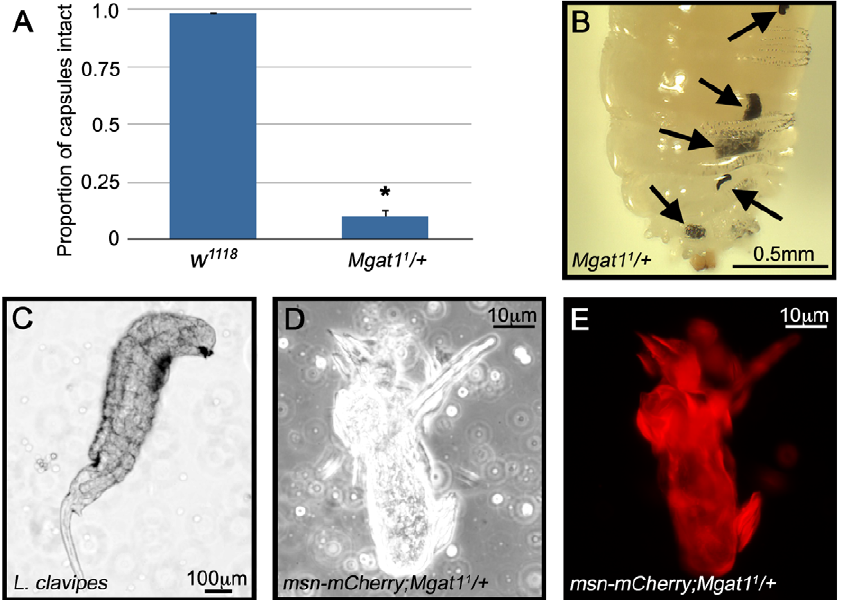
Figure 7. Mgat1 mutant encapsulations break down over time. L. clavipes attacked larvae were scored for the presence of a melanized capsule at 24–48 hours PA, allowed to age a further 24 hours, then scored again. (A) Proportion of w 1118 (blue bars) and Mgat1 1 / + (green bars) capsules that remained intact at 48–72 hours PA. Error bars indicate standard error of the mean; * indicates p , 0.01 relative to control. (B) Brightfield image of a Mgat1 1 / + larva with broken capsule pieces indicated by arrows. (C) All of the Mgat1 1 / + larvae with this phenotype contained live wasp larvae. (D,E) Brightfield and fluorescent images of a broken capsule piece from a msn-mCherry;Mgat1 1 / + larva. The piece was composed largely of mCherry positive lamellocytes. Scale bars indicate 0.5 mm in B, 100 m m in C and 10 m m in